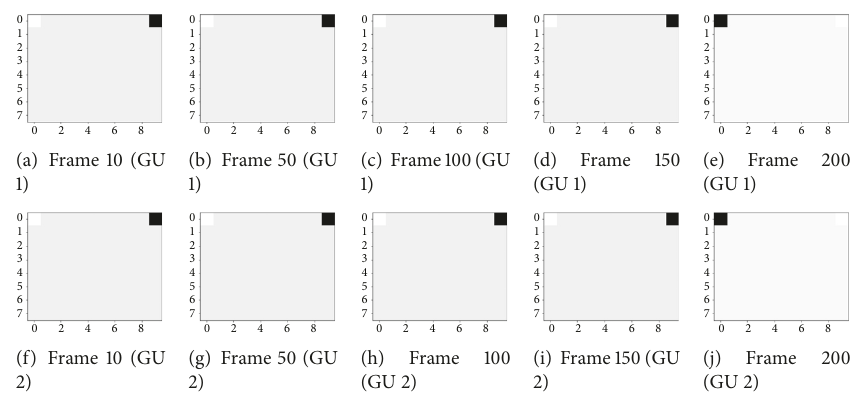
Figure 20: Representation in GU Units (Layer 3) (Crazy turn).